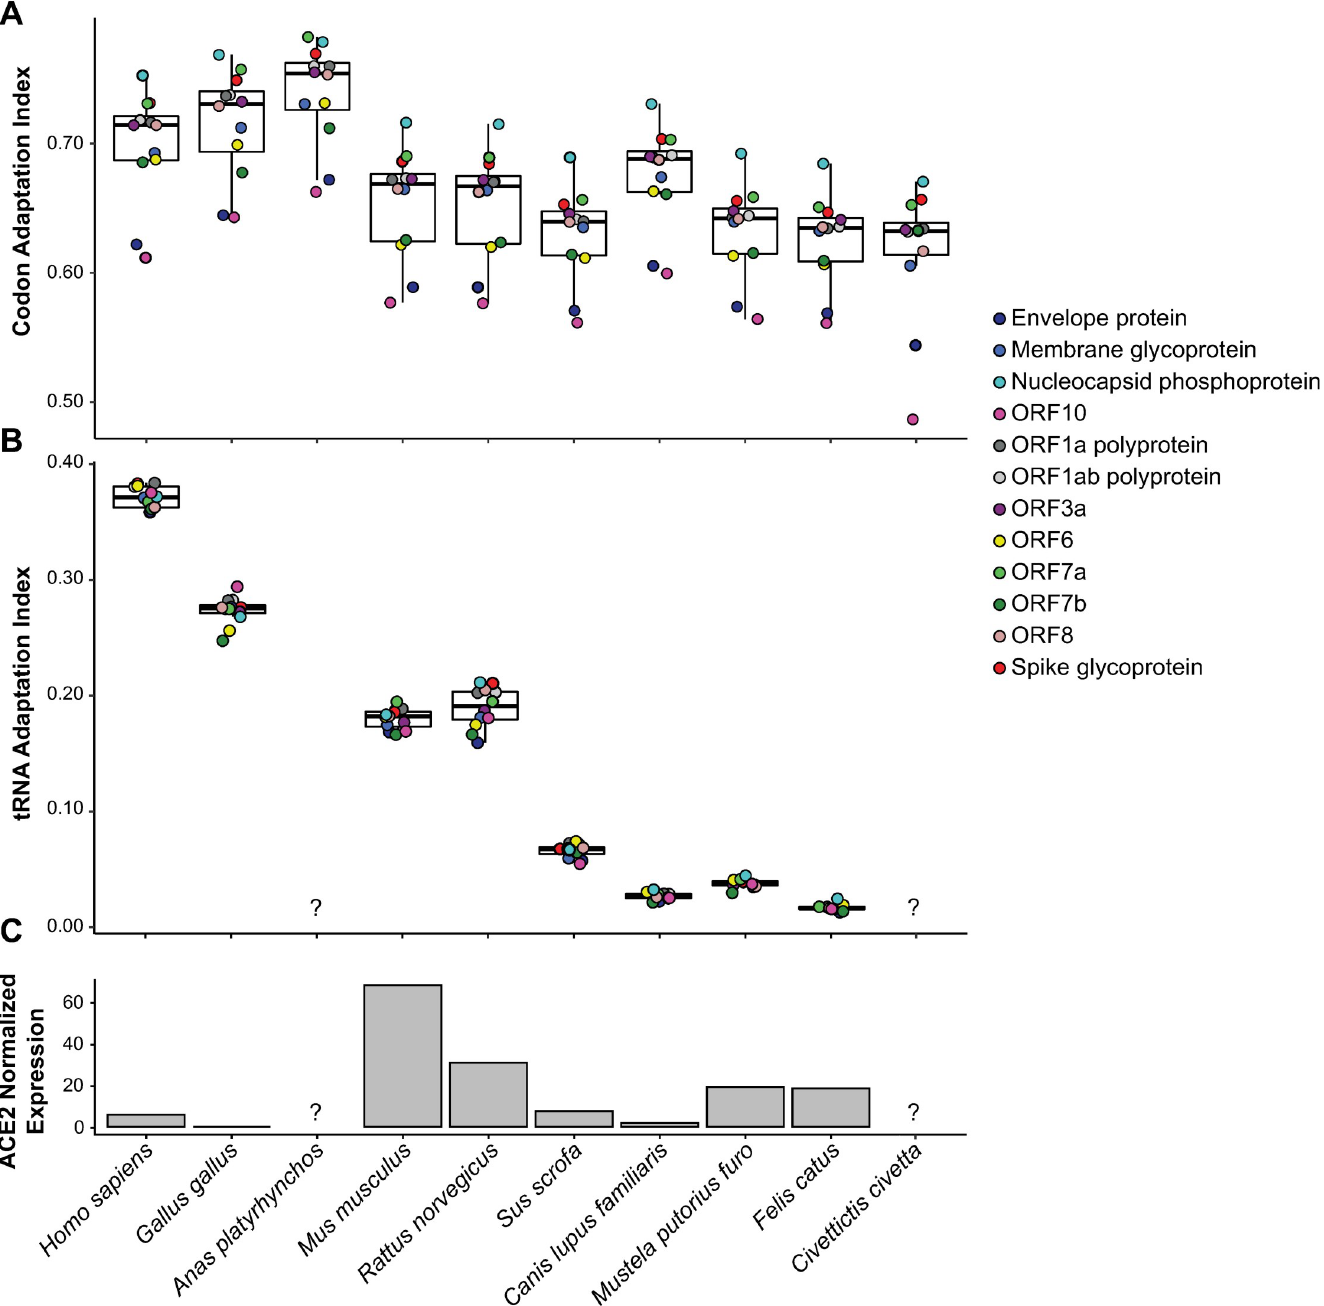
Fig 3. SARS-CoV-2 translational efficiency and ACE2 expression across species. (A) Codon Adaptation Index (CAI) of all viral proteins across different species. (B) tRNA Adaptation Index (tAI) of all viral proteins across different species. Boxes expand from the first to the third quartile, with the center values indicating the median. The whiskers define a confidence interval of median ± 1.58 � IQR/sqrt(n). (C) Median ACE2 gene expression in lung tissues of each species, normalized by the house- keeping gene ACTB. RNA-seq expression levels were retrieved from Sun et al. (2020) or from the Bgee database [42].